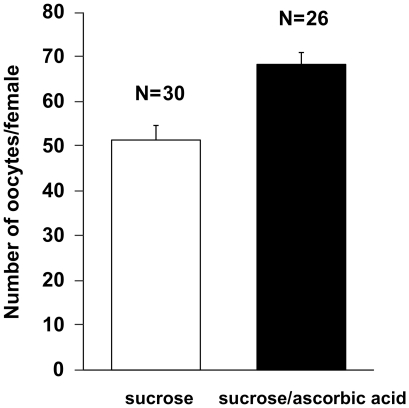
Effect of ascorbic acid supplementation on fecundity in Lu. longipalpis.Flies were blood-fed 9 days Post-Emergence and bar chart represents average number of oocytes dissected 5 days after blood meal ± SEM (combined samples derived from 2 independent experiments). Sand flies fed on 20 mM ascorbic acid-supplemented 70% sucrose solution show significantly higher oocyte numbers in comparison to control sand flies (P<0.0001, t-test).